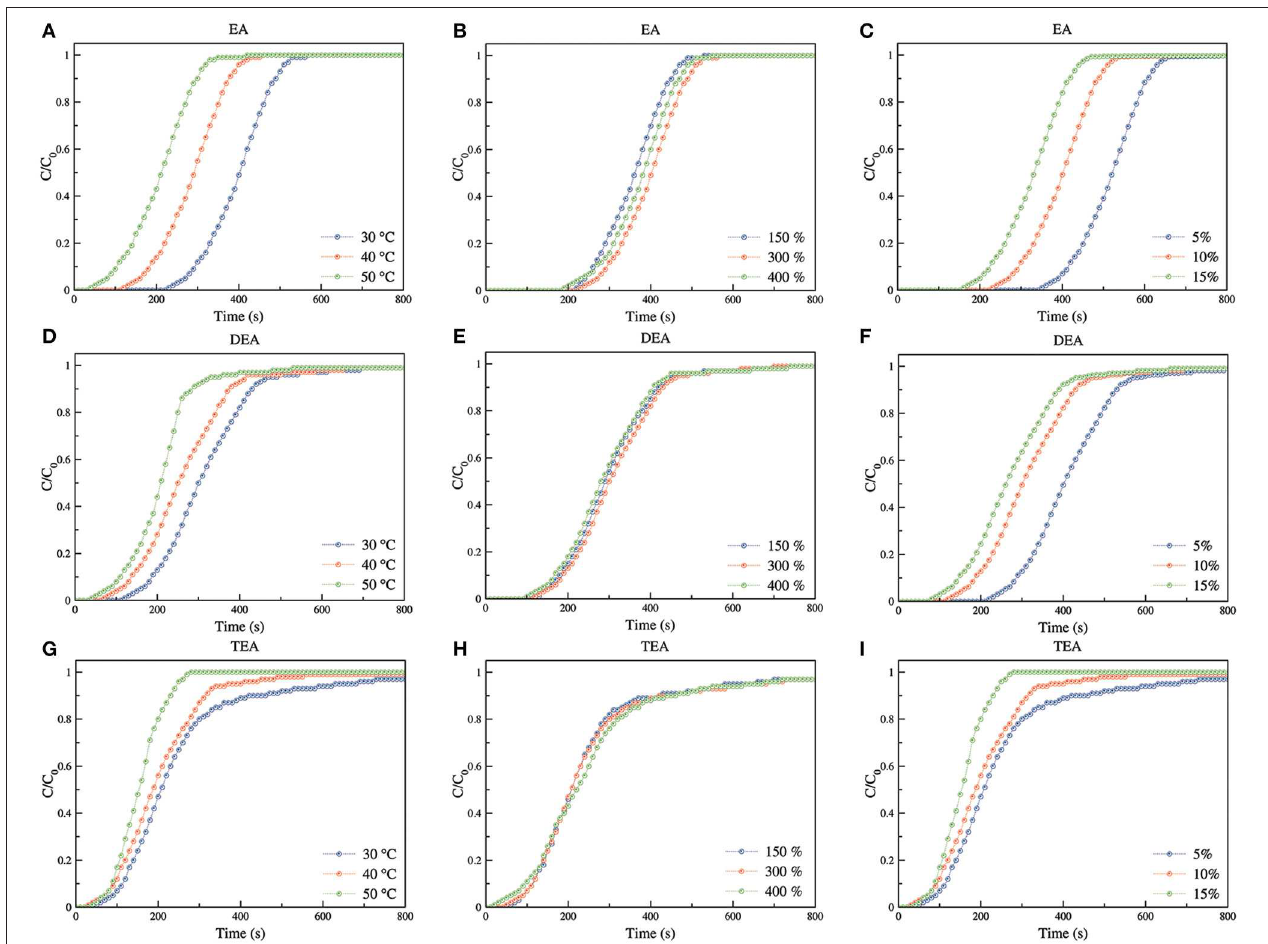
FIGURE 8 | CO 2 adsorption breakthrough curves for EA (A–C) , DEA (D–F) , and TEA (G–I) aminated samples at different temperatures (A,D,G) (C = 10%; DG = 300%; DA = 94%), various DG/amine density (B,E,H) (C = 10%; T = 30 ◦ C), and different feed concentration (C,F,I) (DG = 300%; DA = 94%; T = 30 ◦ C).